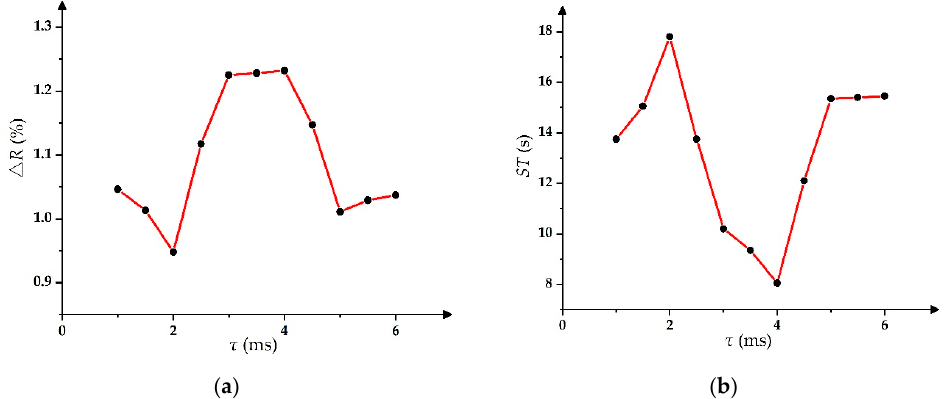
Figure 7. The relationship among parameters of the exponential-function-driving waveform. ( a ) The relationship between τ and ∆ R . ( b ) The relationship between τ and the stable time.